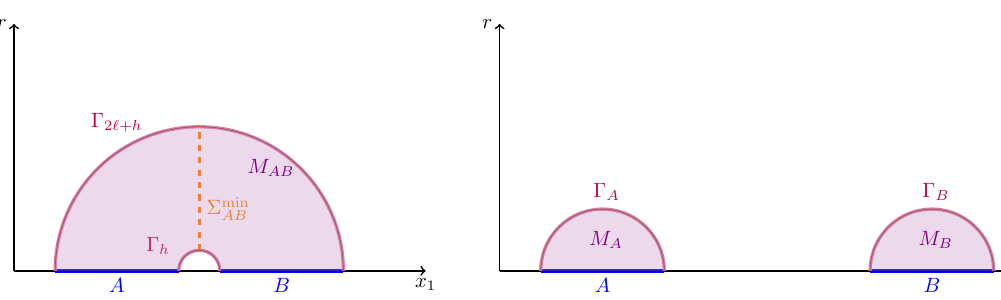
Figure 9 . Illustrations of the connected and disconnected RT surfaces which contribute to the HMI as well as EW for a bipartite system A ∪ B . Left ) Connected configuration: the two entangling regions A and B are close enough to each other such that the RT surface corresponding to S AB is given by Γ Γ which are shown by the solid purple curves. In this case, the EW is also h ∪ 2 ‘ + h connected and indicated by the shaded violet region. The minimal surface Σ min which measures AB the minimal cross section of EW is indicated by an orange dashed curve. Right ) Disconnected configuration: the two entangling regions are far enough from each other, such that the RT surface corresponding to S is disconnected and given by Γ Γ shown by purple solid curves. Moreover, AB A ∪ B the EW is disconnected and given by M which are indicated by the shaded violet regions. In A ∪ M B this case, the minimal surface Σ min does not exist, and hence E = 0 . Notice that, these diagrams W AB are schematic, and only for the d = 1 case, the RT surfaces are e